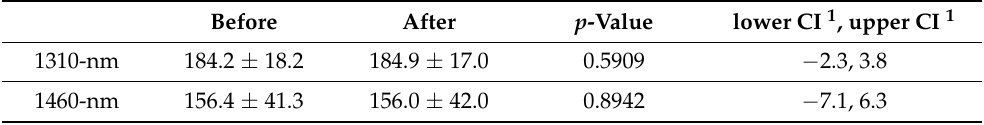
Table A1. Mean ± S.D., 95% confidence interval, and p -value (two-tailed paired t-test) for raw intensity values from NIR SFE measurements of demineralized bovine enamel samples before and after the application and removal of red varnish (n =